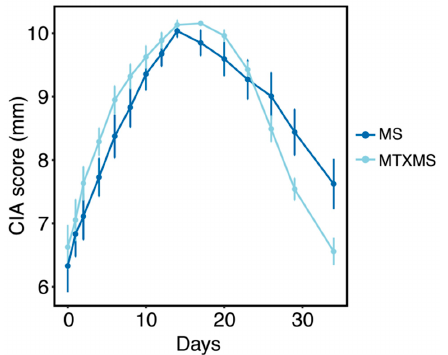
Figure 2. Phenotypic characterization. Standard clinical parameters (paws’ thickness, CIA score, mm) in the mechanical stimulation (MS) and MTX in conjunction with MS arms (MTXMS) over time (34 days) drawn from published data (Data S1), excerpt from [16] . Data are presented as mean ± SEM (Standard Error of Mean).